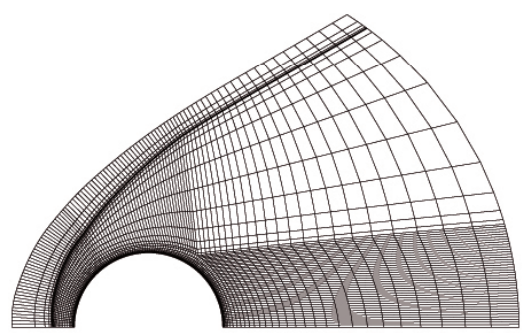
Figure 3. Mesh for the cylinder (each 5th line is represented in each